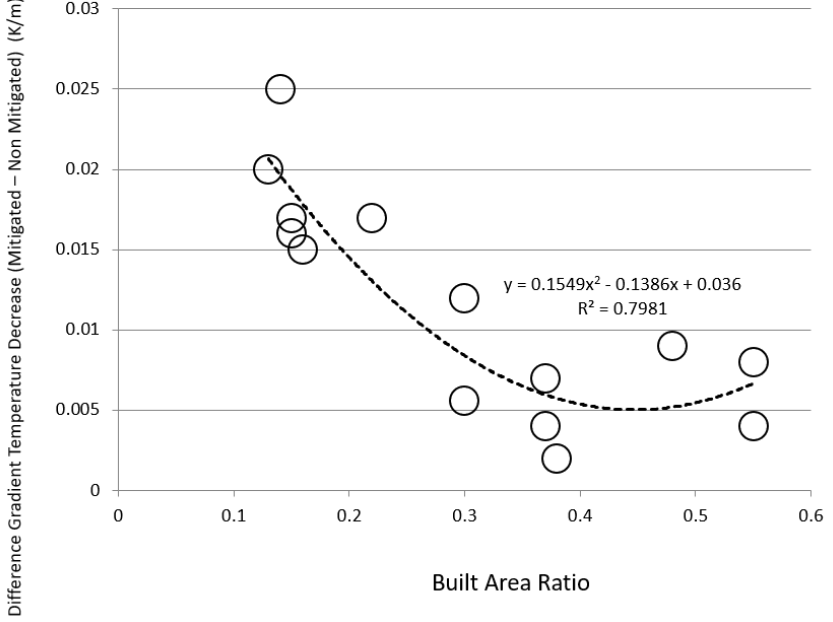
Figure 12. Cooling Efficiency of Mitigation Measures as a function of the Built Area Ratio. A clear and strong correlation is found between the GTD of all the precincts with and without mitigation, and their corresponding average aspect ratio, ( H/W ), (Figure 13). The relation is: where a 2 and b 2 are coefficients provided in Figure 13.